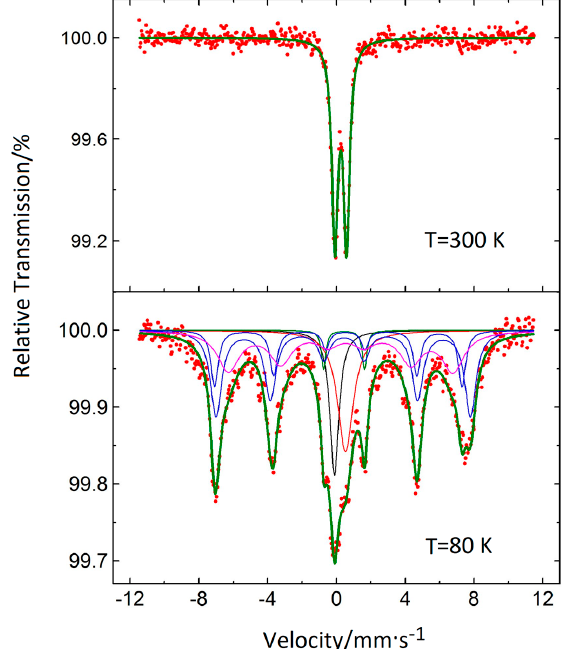
Figure 5. 57Fe Mössbauer spectra measured at 300 K and 80 K for nanorods of zinc ferrite (red dots) along with the result of multicomponent fit (green solid line). Thin solid lines represent the spectra of individual components of spectrum collected at 80 K.